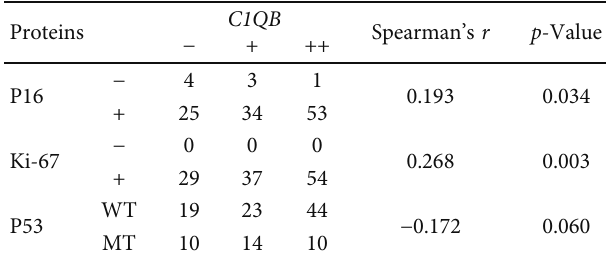
Table 3: Correlation of the C1QB , P16, Ki-67, and P53 expression in cervical